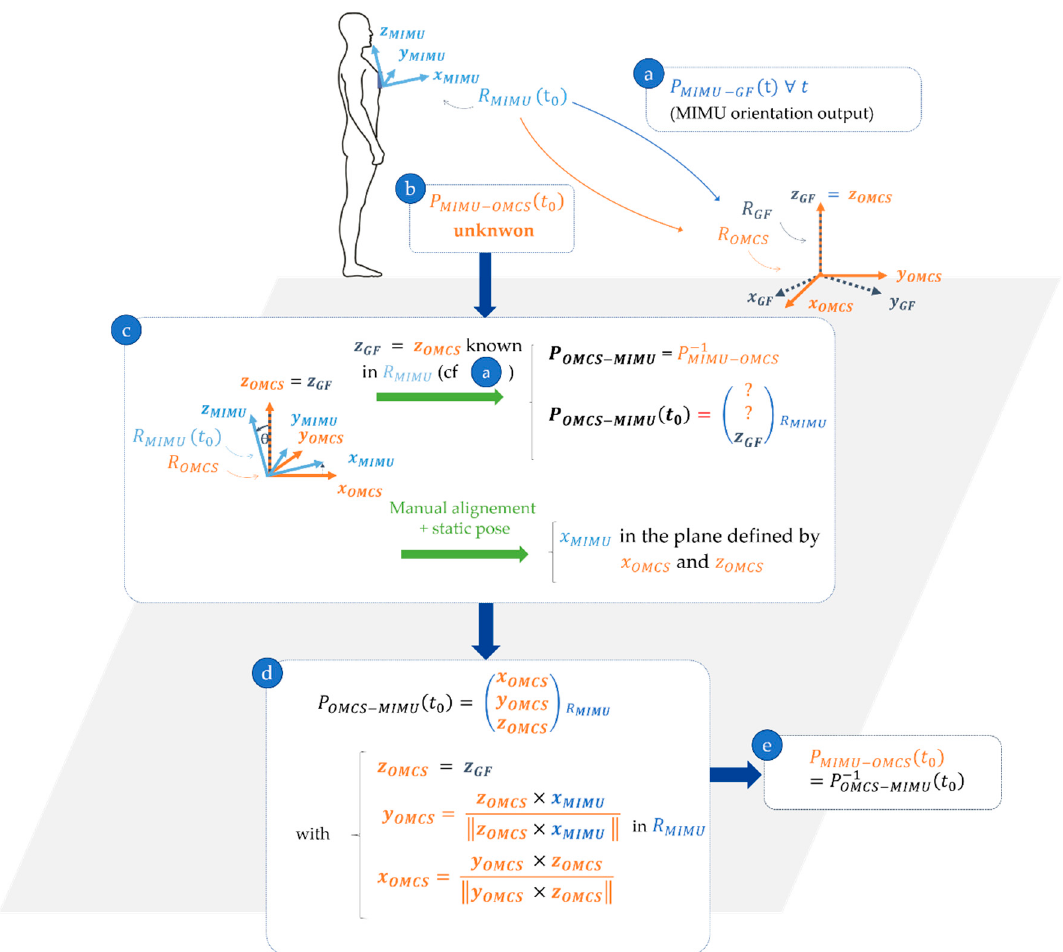
Figure 1. Computation of the orientation of the trunk MIMU local frame in the OMCS reference frame P MIMU − OMCS during the static posture (at t = t 0 ). To determine the orientation matrix, the axes of the OMCS reference frame must be determined in the MIMU local frame. P MIMU − GF is retrieved from the orientation output of the MIMU at t = t 0 ( a ). P MIMU − OMCS is unknown at t = t 0 ( b ) but it might be approximated using ( c ). Using the orientation output of the MIMU, the vertical direction z GF of the MIMU-sensed Earth-fixed frame is known in R MIMU . Furthermore, since MIMUs’ attitude is not affected by magnetic perturbations, the vertical direction detection by MIMUs is robust and is consistent with that of the OMCS global frame R OMCS . Therefore, z GF = z OMCS in R MIMU . The manual alignment of the MIMU on body segments and the static posture taken by the participant allows assuming that the x axis of the MIMU local frame x MIMU is in the plane defined by x OMCS and y OMCS axes. This in turn can be used to approximate x OMCS and y OMCS in R MIMU ( d ). Lastly, P MIMU − OMCS is obtained at t = t 0 as the inverse of P OMCS − MIMU ( e ). From Equations (2) and